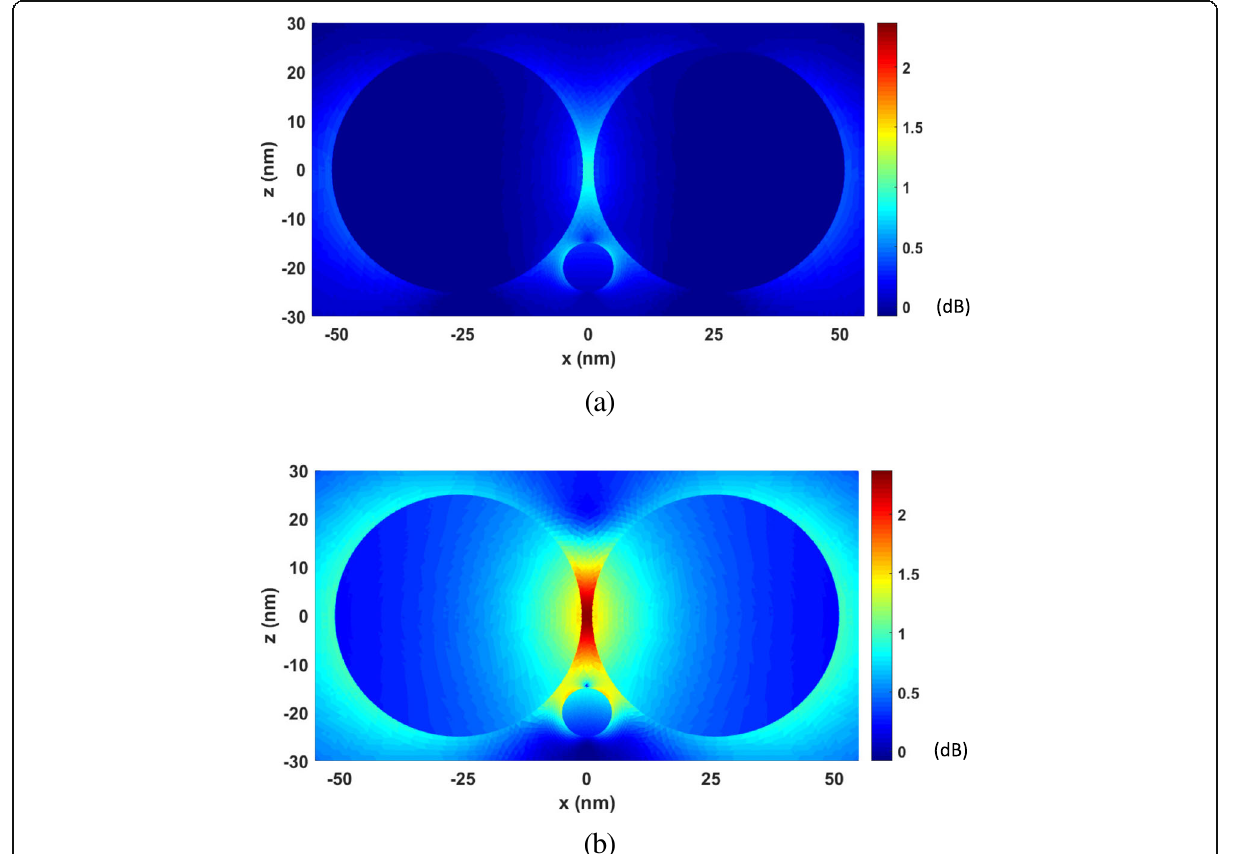
Fig. 7 The electric field enhancement distributions on the xoz plane for the system of gold nanosphere dimer. a λ = 300 nm (non-resonance wavelength). b λ = 472 nm (resonance